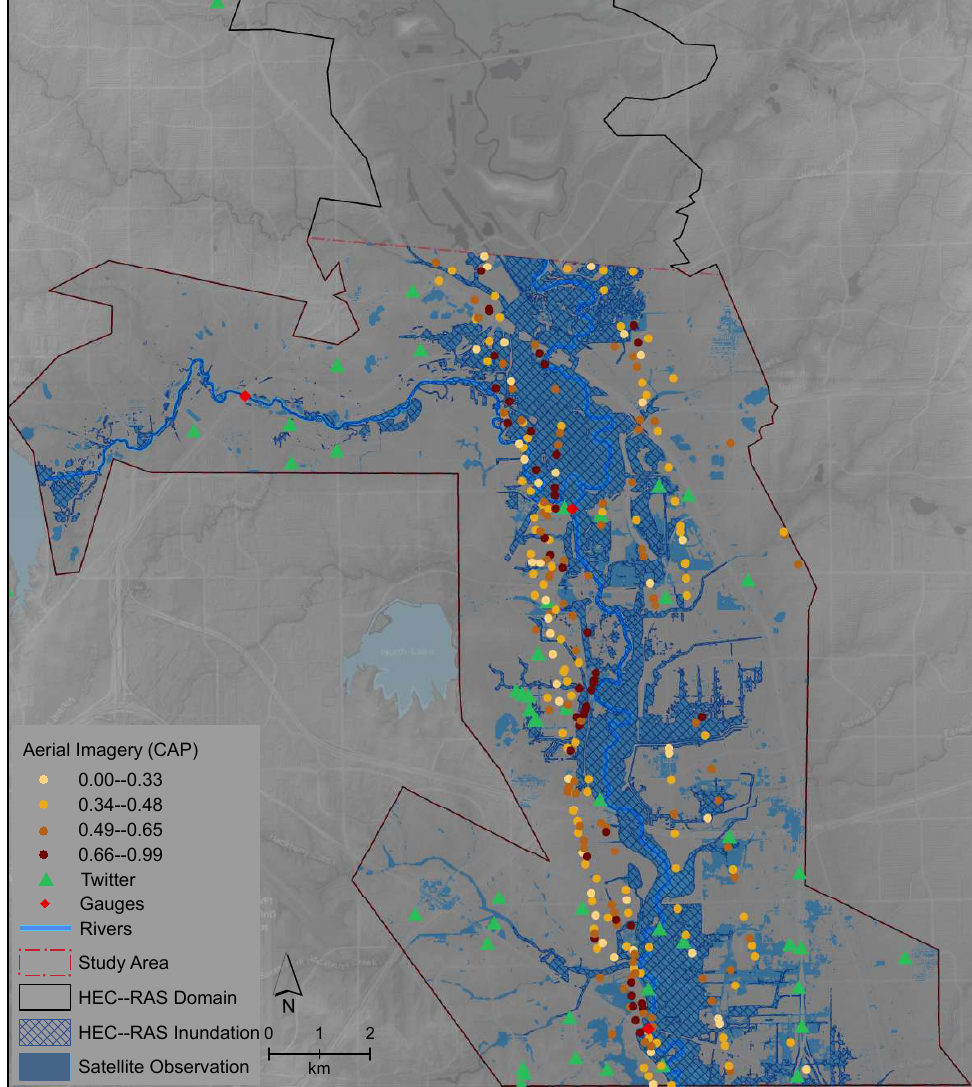
Figure 1. Study area showing the various sources of multispectral remote sensing contributed, and open source geospatial data collected and fused to estimate flood extent. The HEC-RAS model inundation is overlaid and represented with a hashed